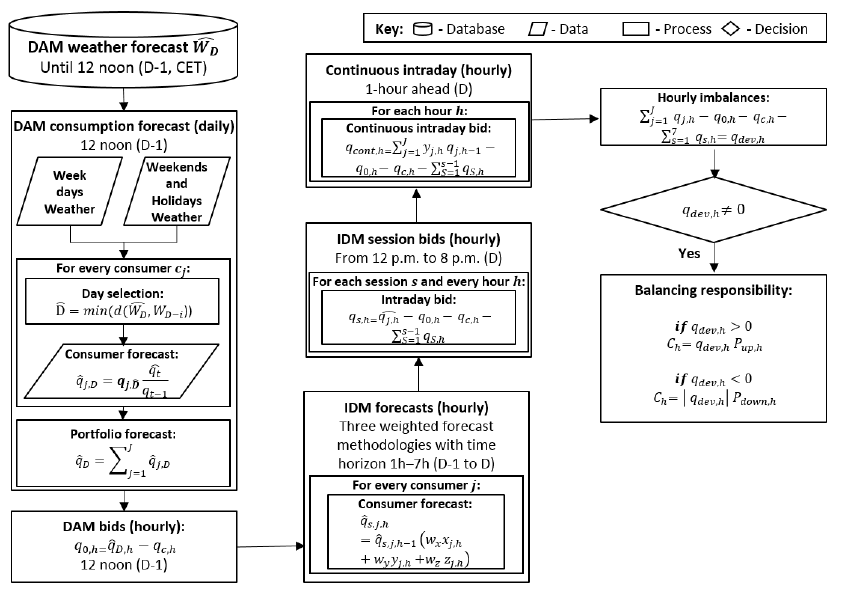
Figure 1. Strategic bidding process of retailers in wholesale